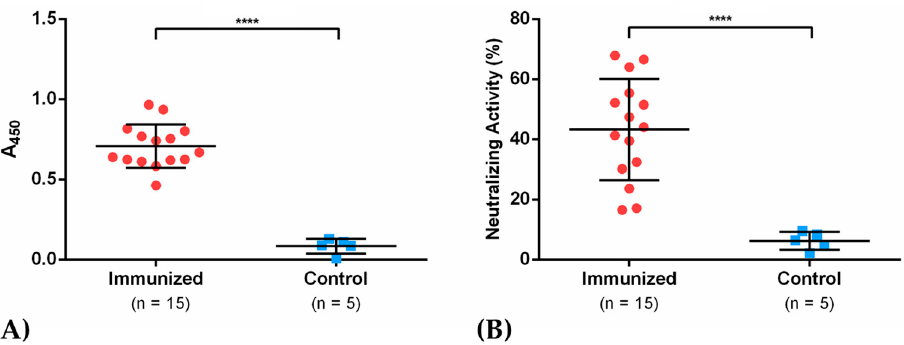
Figure 6. IgG antibody titers in mice sera ( A ) and neutralization activity through sVNT ( B ) in mice immunized with the NG19 antigen. **** indicates a significance level of p <